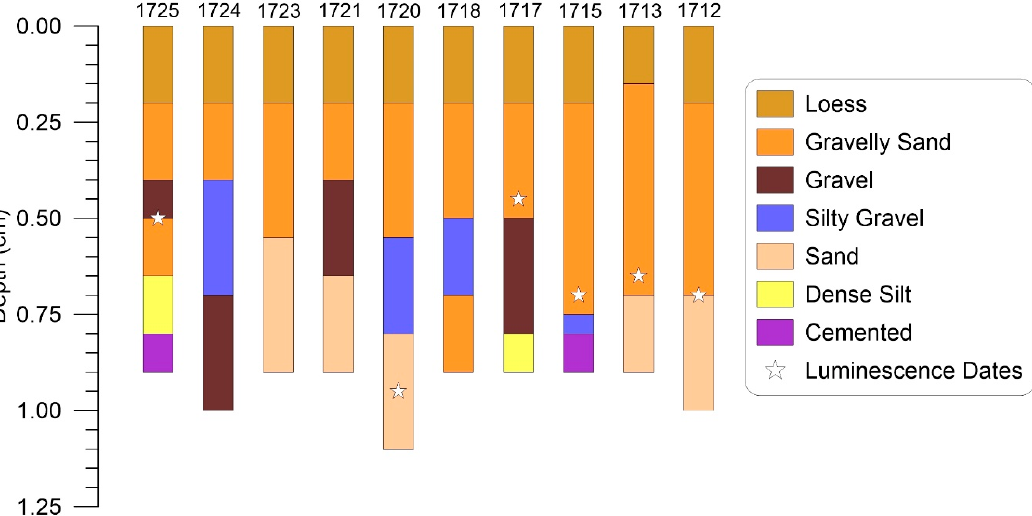
Figure 10. Simplified stratigraphic logs for the pits excavated into the Lake Clover shorelines, designated by their corresponding lake elevations (Table 1). All are capped by a layer of silt interpreted as loess, which overlies a gravelly sand layer. Alternations between finer (silty gravel) and coarser (gravel) sediment are present at depth. Five pits bottomed in fine sand, whereas two reached a layer of dense silt. Three excavations encountered a carbonate cemented layer. The depths of the six dated luminescence samples are shown by the stars.